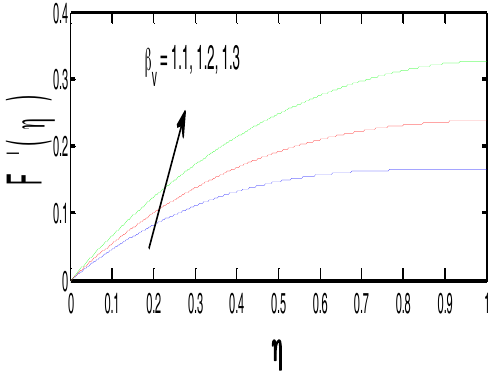
Figure 2. Impact of β υ with dusty particles on velocity profile F (cid:48) .